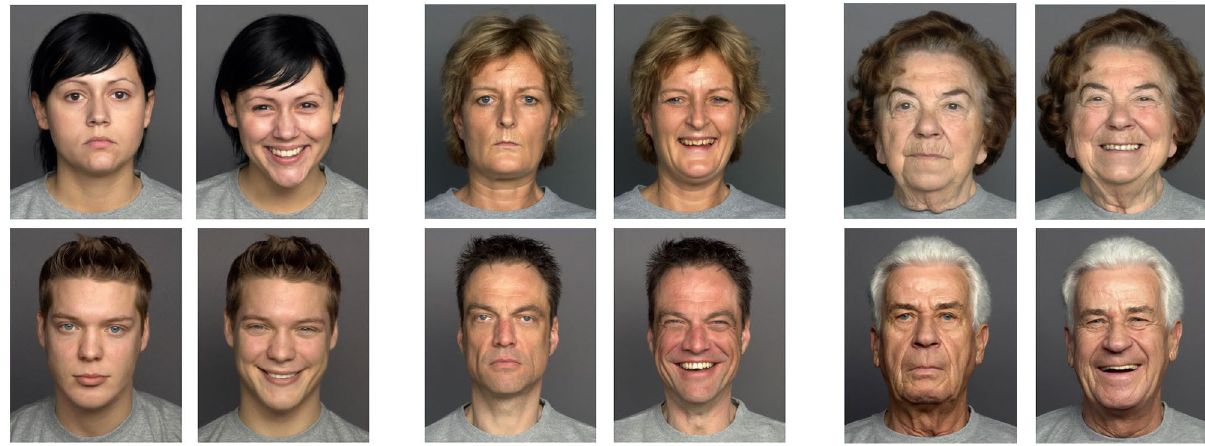
Figure 1. Examples of stimuli used in the study. The images were of neutral and smiling faces of young adults, middle-aged adults, and old adults. Adapted from Ebner et al. 20 , all right